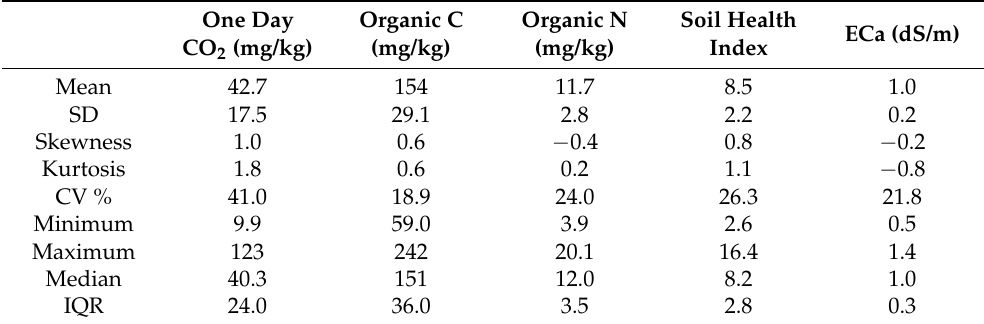
Table 2. Summary statistics of soil health indicators, soil health index, and apparent electrical conductivity measured at sample locations ( n =